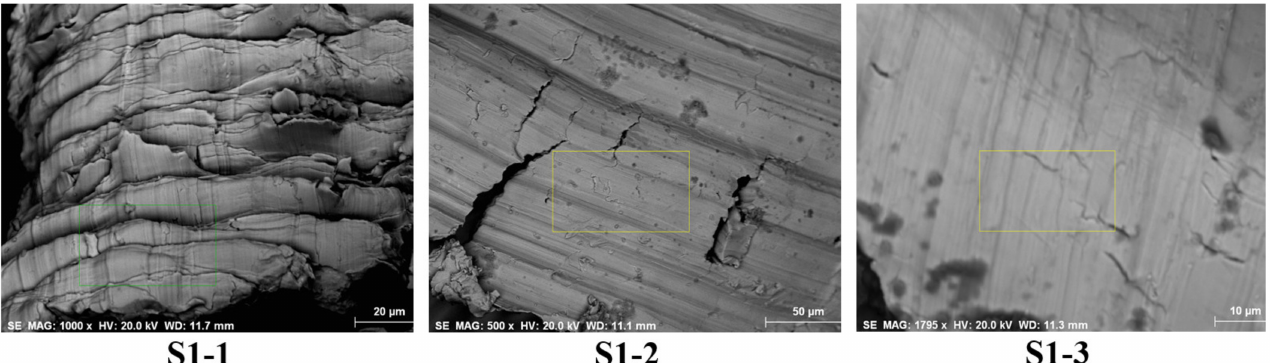
Figure 3. Areas selected for analysis, marked S1-1, S1-2 and